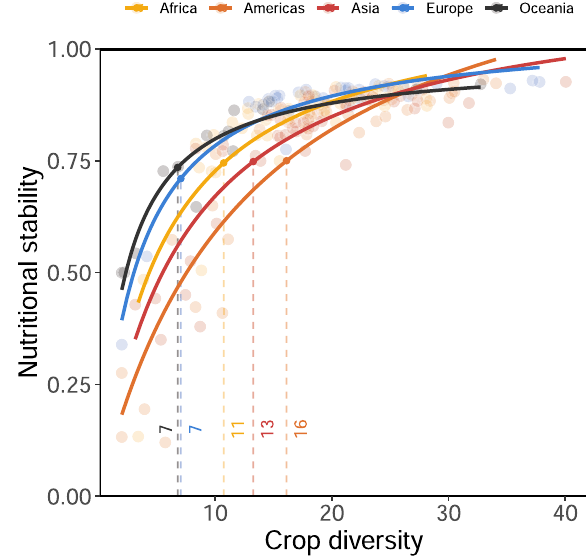
Fig. 2 Nutritional stability increased non-linearly with crop